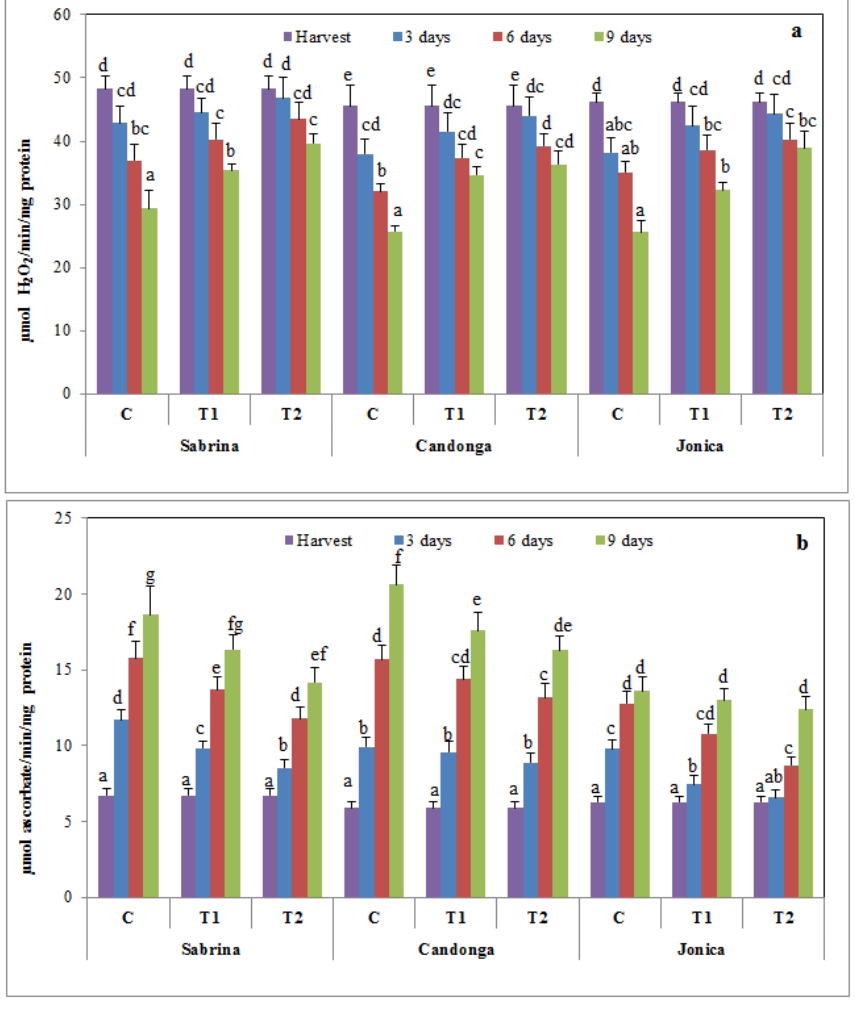
Figure 5. Changes in catalase (CAT) ( a ) and ascorbate peroxidase (APX) ( b ) activity of strawberry cultivars during cold storage at 2 °C for nine days (error bars indicate standard